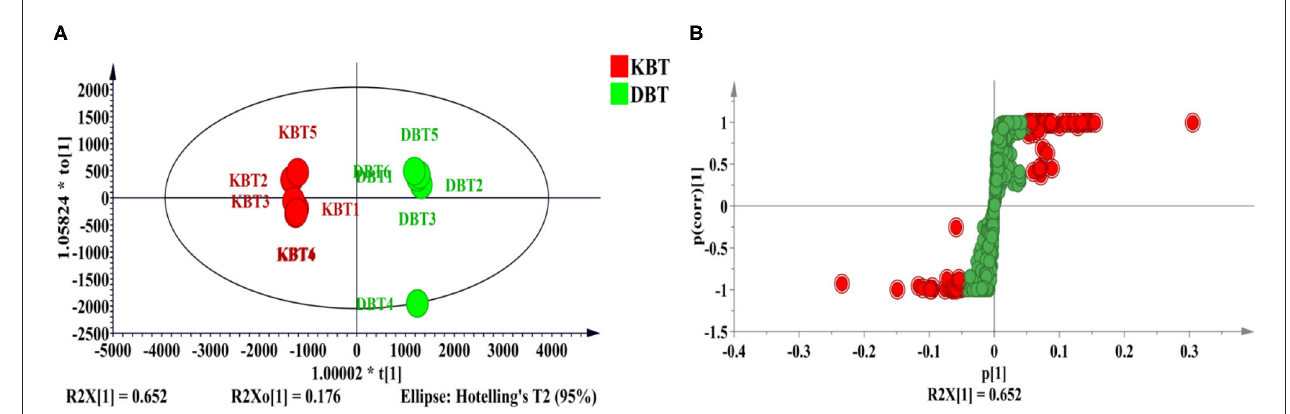
FIGURE 1 | Multivariate analysis of compounds detected in mass spectrometry. Keemun black tea (KBT), Dianhong black tea (DBT). (A) OPLS-DA; (B)